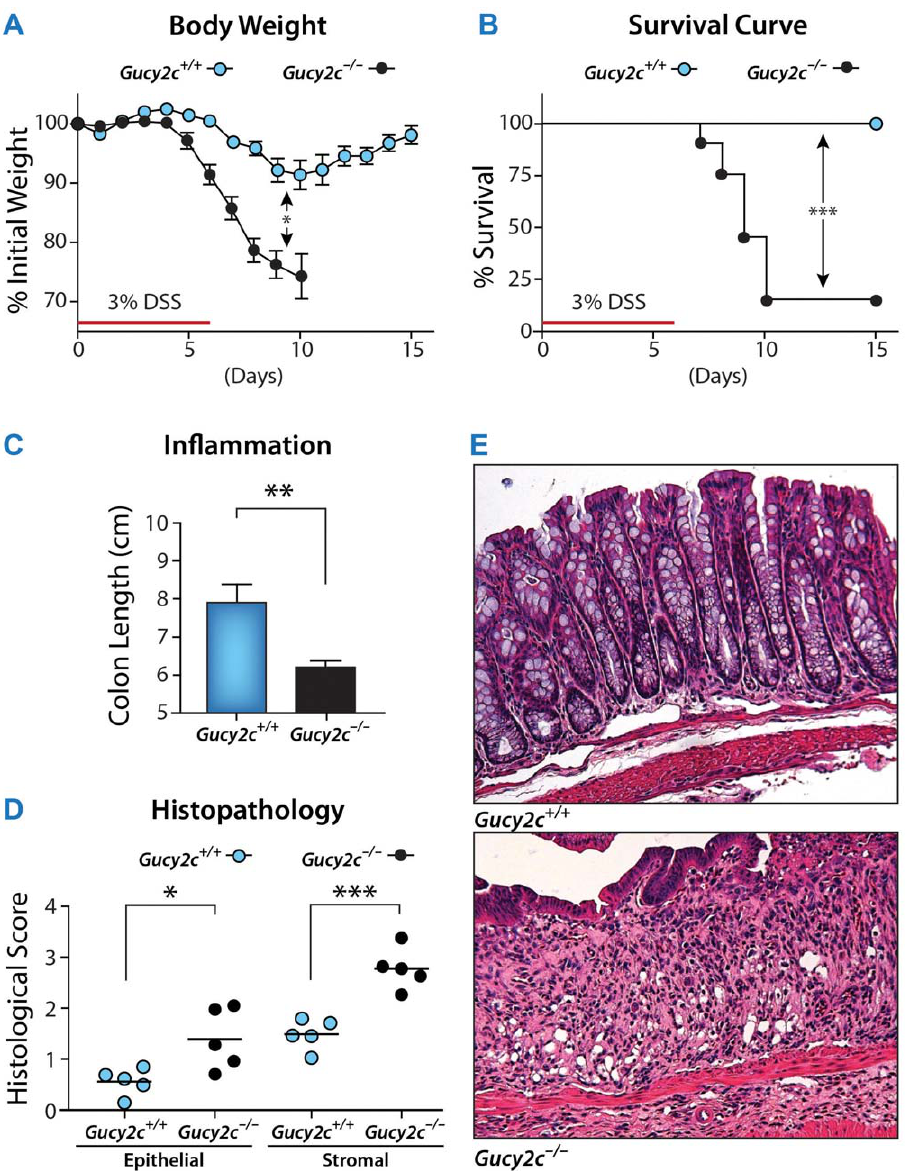
Figure 2. GUCY2C-deficiency increases susceptibility to DSS-induced colitis. Gucy2c + / + and Gucy2c 2 / 2 male mice were administered 3% DSS in drinking water for 7 d to disrupt the epithelial barrier and induce colitis. Severity of colitis was analyzed by ( A ) body weight (n=11) and ( B ) survival (n $ 11). ( C ) Colon length was measured from the colocecal junction to the anal verge on day 12 (5 d post-DSS exposure) to quantify chronic inflammation. ( D ) Histological sections obtained from jejunum and distal colon on day 12 were stained with H&E and scored for epithelial and mesenchymal inflammation. Each point represents one mouse. ( E ) Representative H&E colon sections (20 6 ). Data are mean 6 SD (in C) and SEM (in D) obtained from one of three independent experiments. **, p , 0.01, ***, p ,